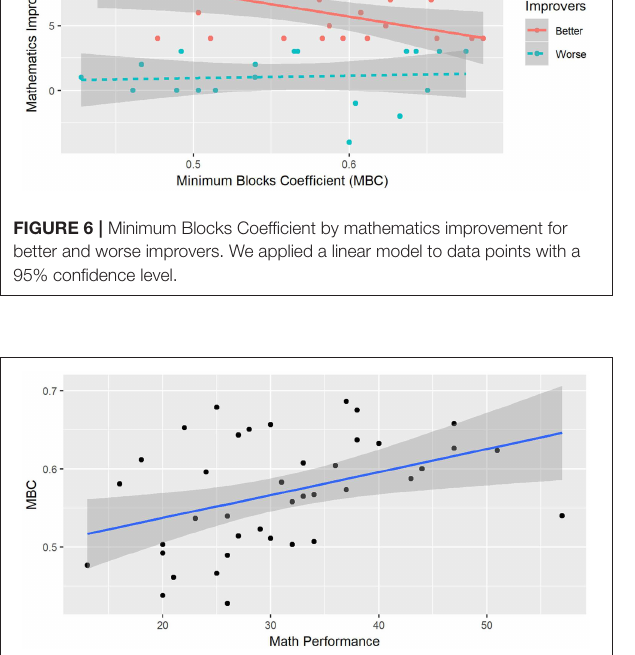
performance (Pre-Test scores). Analysis indicated that Pre-Test scores were positively correlated with the MBC (cor = 0.41, p = 0.009; see Figure 7 ). Children who had greater Pre-Test scores